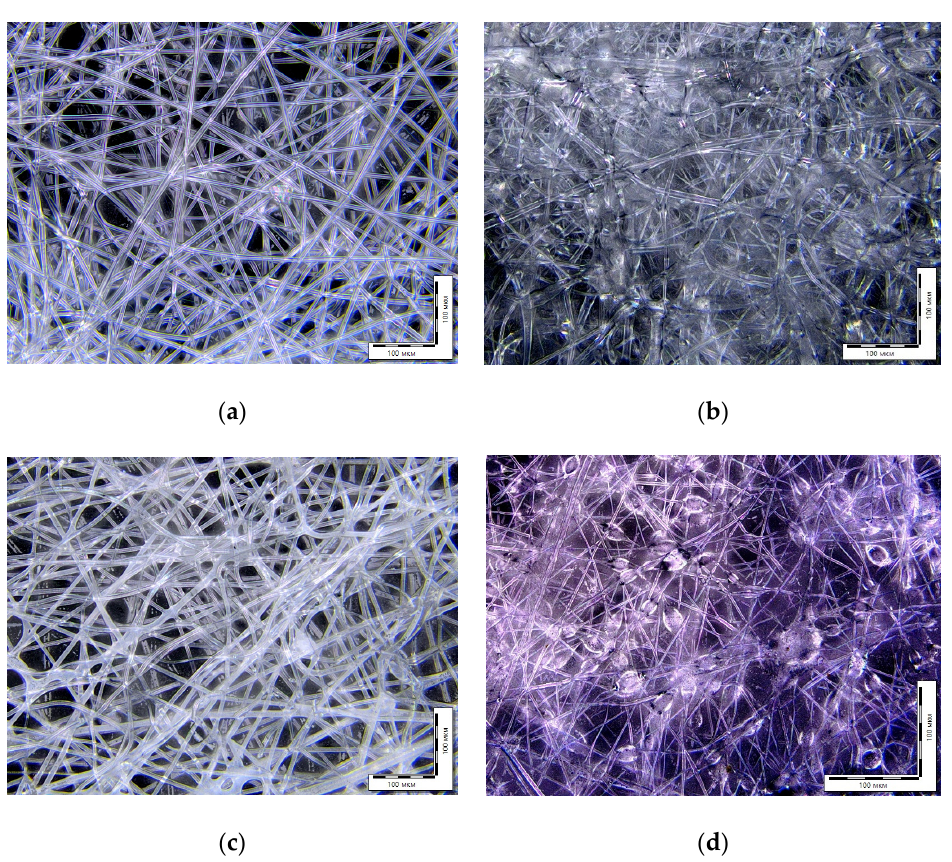
Figure 2. Optic micrographs of nonwoven fabric samples PLA ( a ), 85PLA/15NR ( b ), PHB ( c ), and 85PHB/15NBR ( d ).